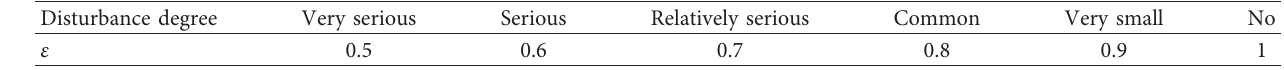
Table 1: Pedestrian interference correction coefficient.